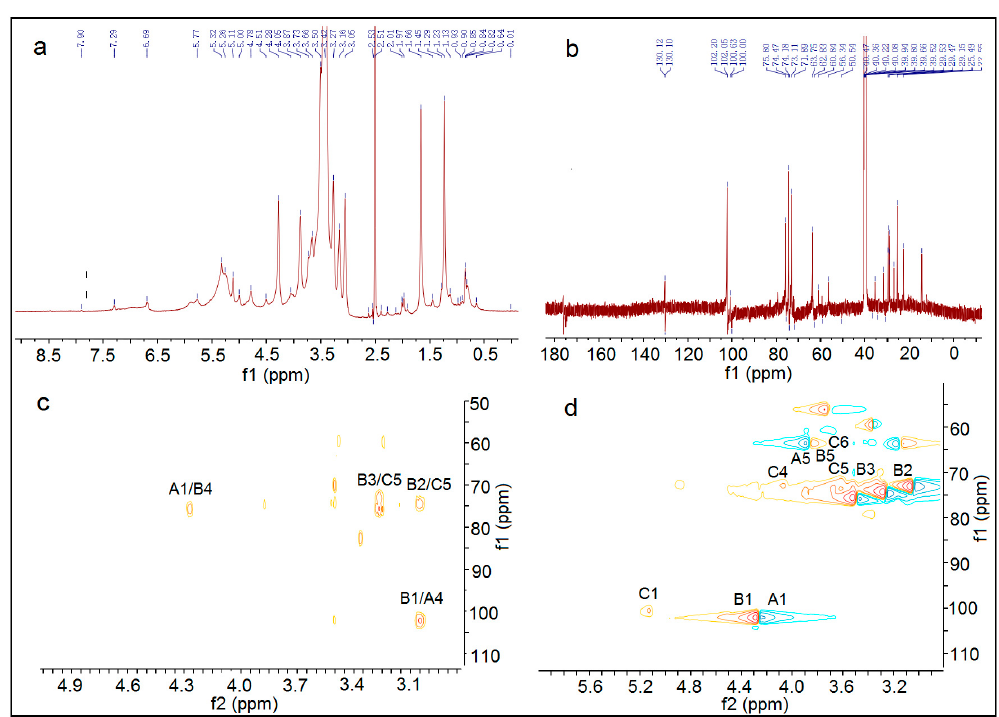
Figure 6. 1 H-NMR ( A ), 13 C-NMR ( B ), HMBC ( C ), and HSQC ( D ) Spectra of AX-I-3b.